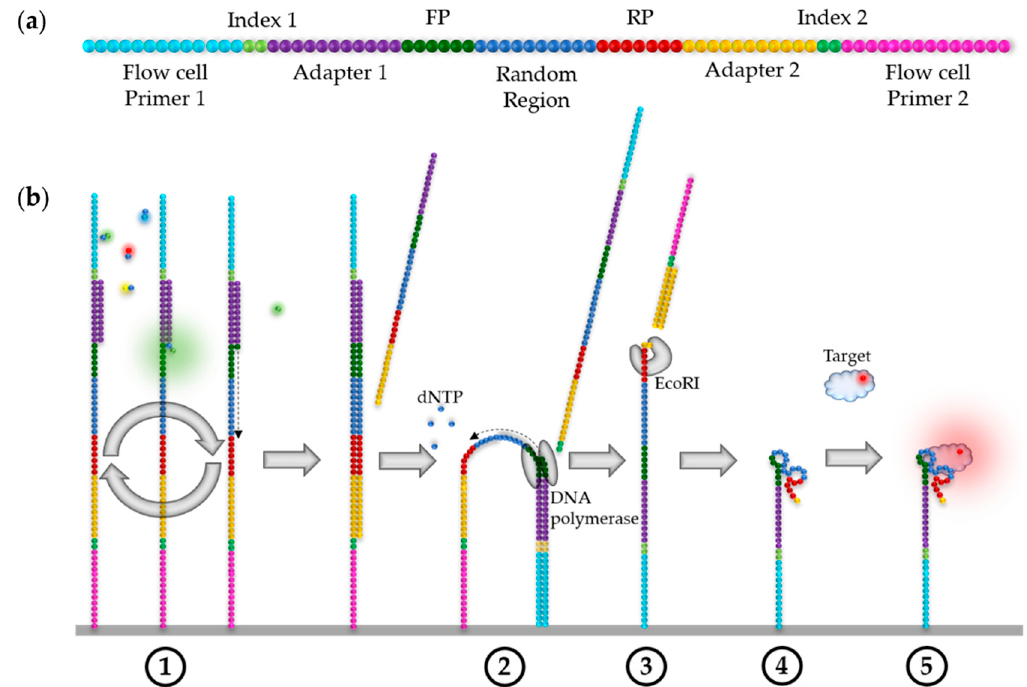
Figure 3. Schematic illustration of the HiTS–FLIP experiment for ssDNA aptamers, according to Wu et al. [28]. ( a ) The initial DNA library, designed for paired-end sequencing. A restriction enzyme (EcoRI) recognition sequence is inserted between the reverse primer and adapter 2. One dot generally corresponds to ~3 nt; however, the possible length of the randomised core is highly variable, ranging from ~10–600 nt; FP: forward primer; RP: reverse primer. ( b ) The HiTS–FLIP process for ssDNA; dNTP: Deoxyribonucleotide triphosphate.